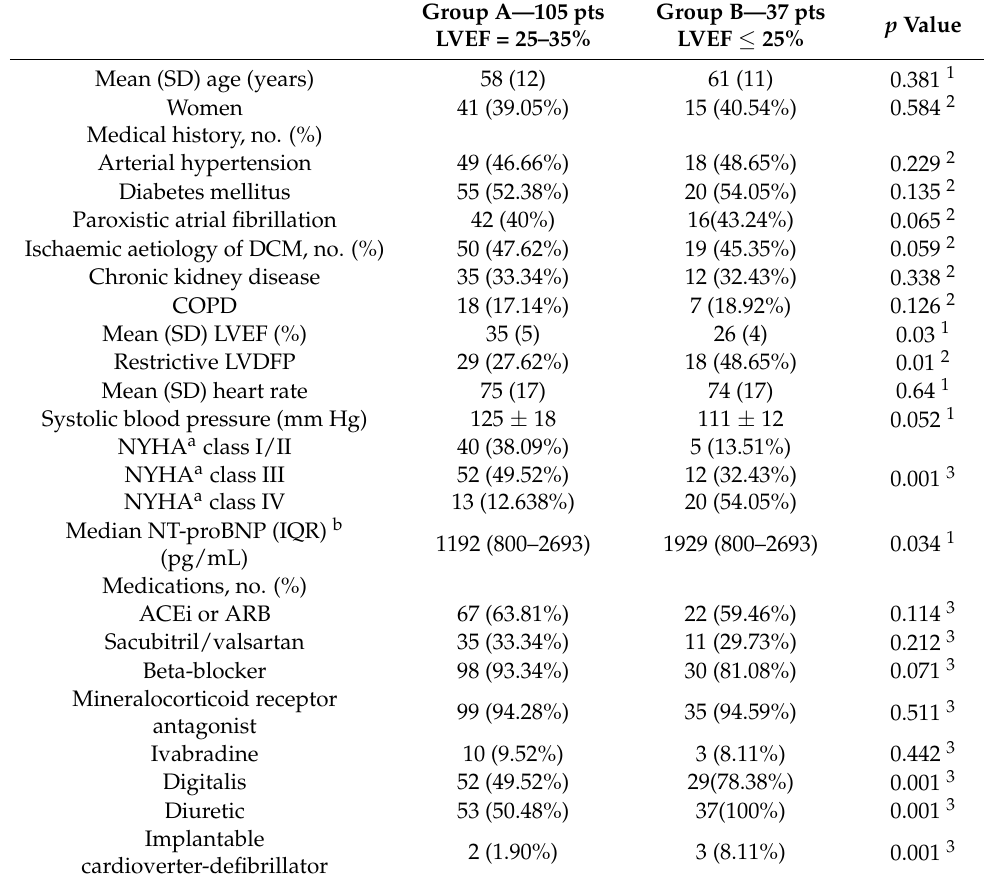
Table 1. Baseline clinical and demographic characteristics of the patients n =